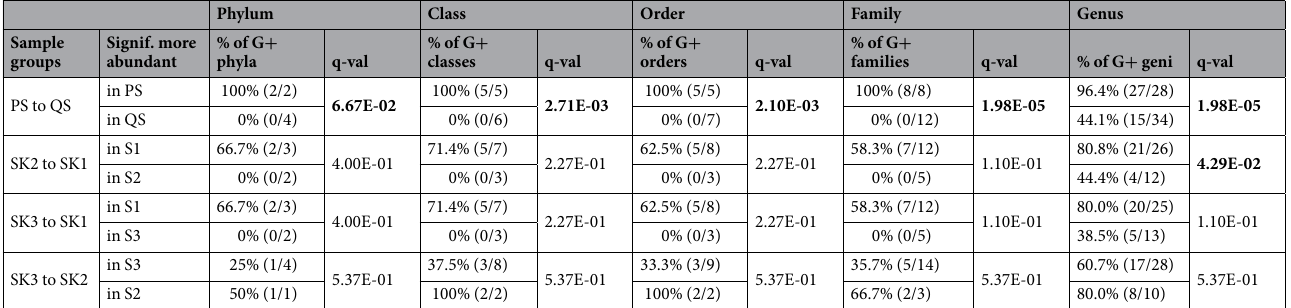
Phylum Class Order Family Genus